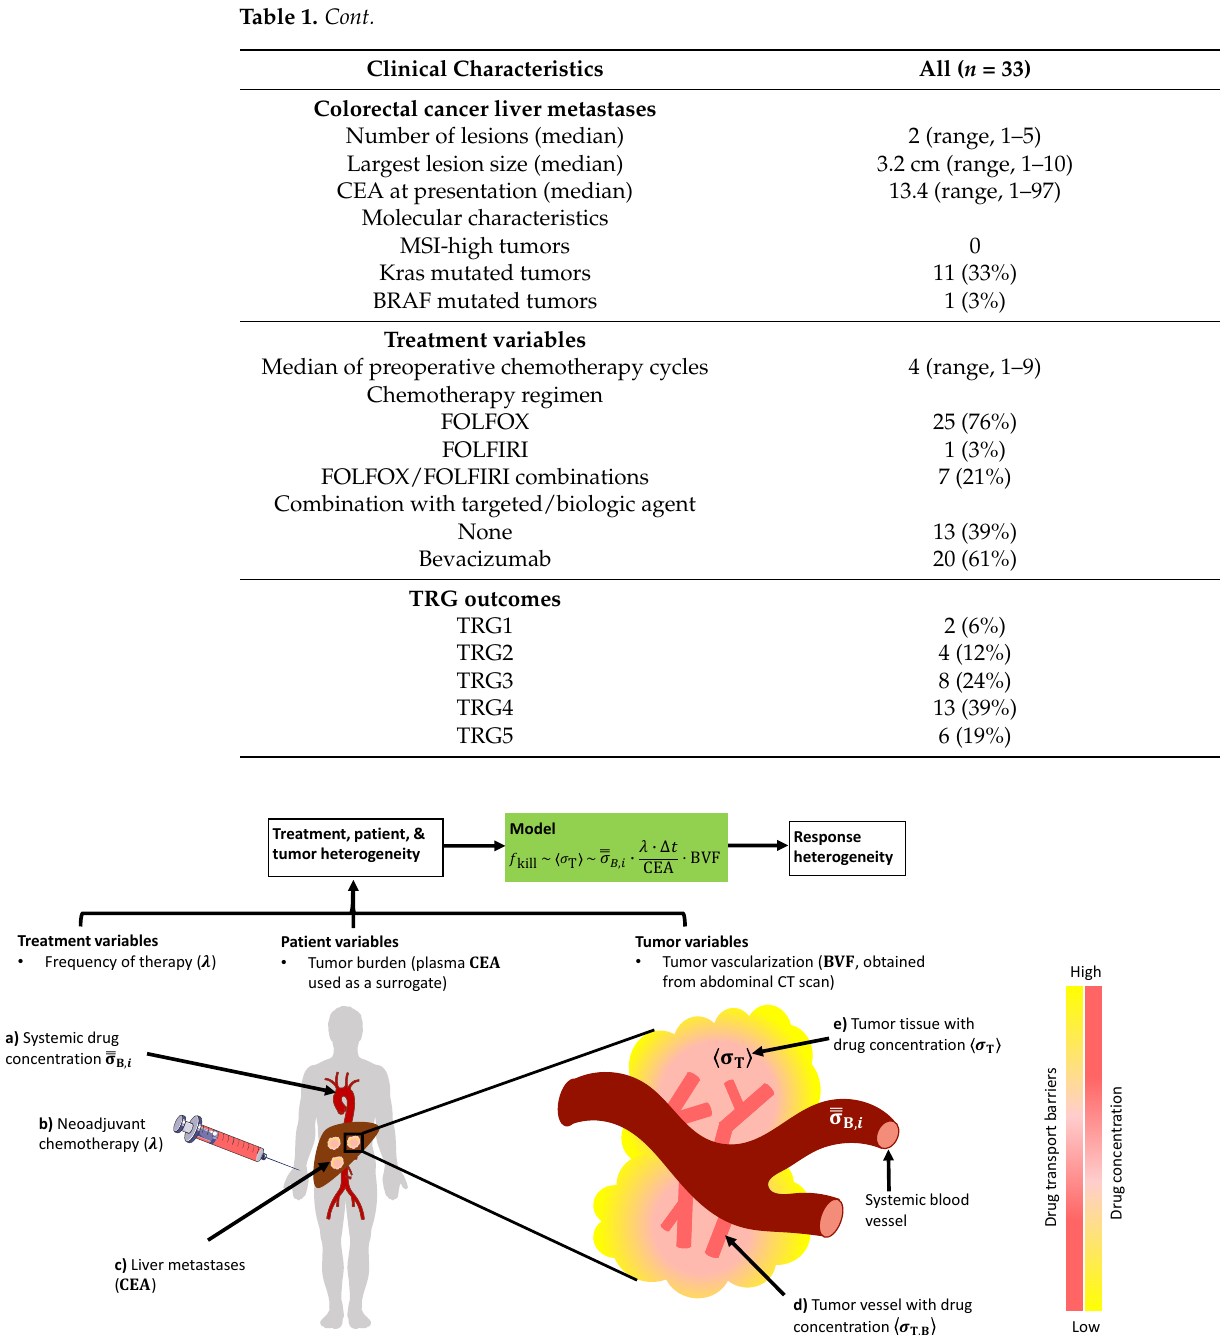
Figure 1. Schematic description of the mathematical model and its variables. The model presented here takes as input the treatment, patient, and tumor-related variables to predict tumor response to chemotherapy. ( a ) Calculated systemic drug concentration, as obtained through pharmacokinetic analysis of patient-specific dosage regimen, is scaled by the ( b ) frequency of drug administration and ( c ) total tumor burden (surrogate: serum carcinoembryonic antigen (CEA)) to provide an estimate for ( d ) tumor vascular drug concentration, which upon further scaling with the tumor blood volume fraction (BVF), estimates drug concentration in the ( e ) tumor interstitium, which correlates directly with response. Note: Normalized area under the curve (AUC) of contrast enhancement kinetics in abdominal CT (computed tomography) scan provides a measure of tumor BVF. Δ t is the duration of a single therapy cycle. Color gradients denote level of drug concentration and drug diffusion barriers in the tumor. Illustration is not to scale.